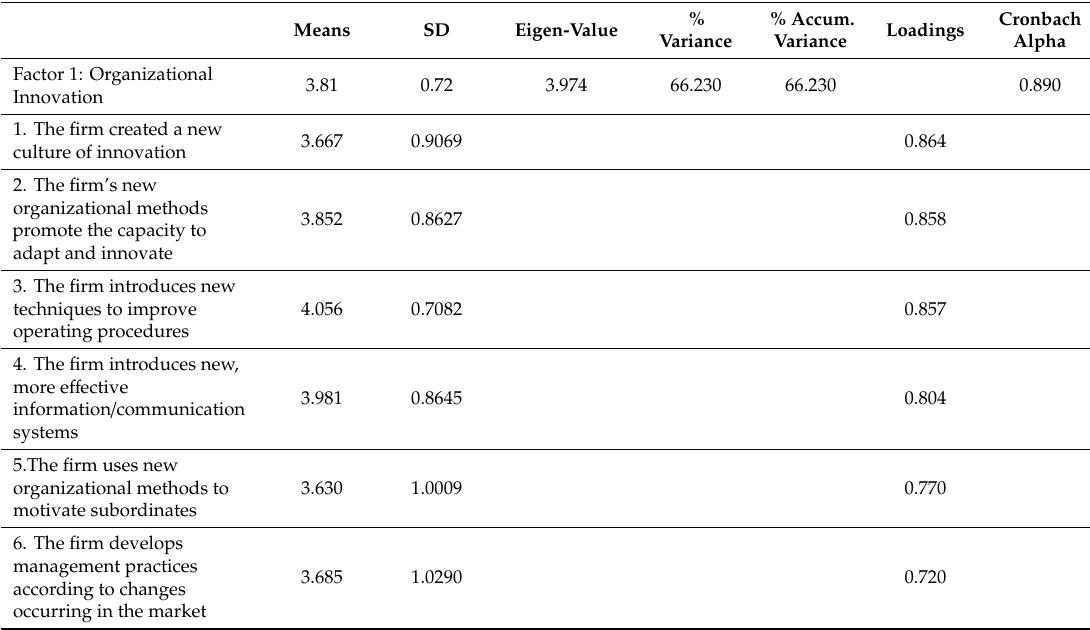
Table 4. Factor Analysis of Organizational Innovation.